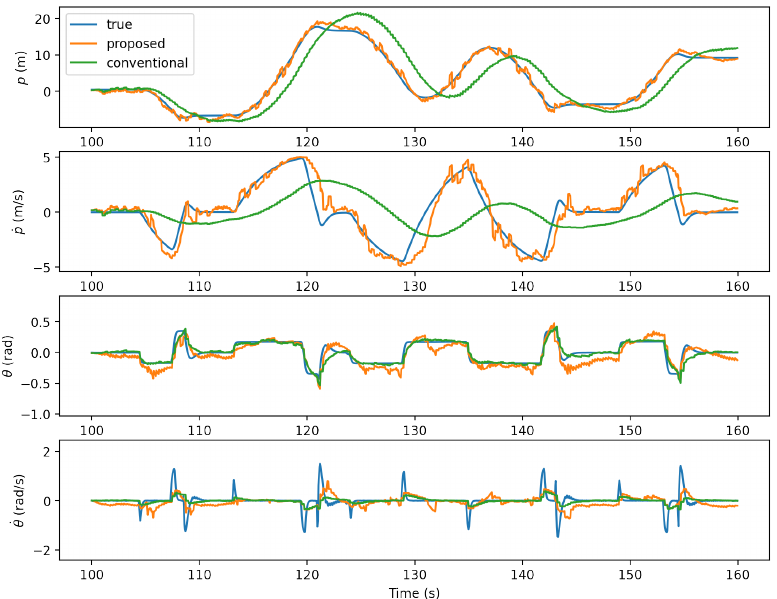
Figure 12. State estimation by the proposed and the conventional